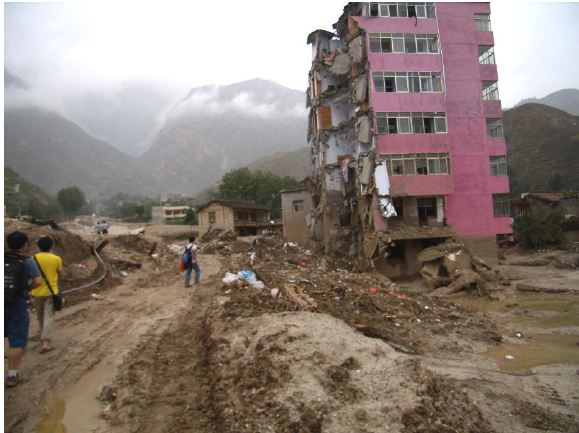
Fig. 12. The devastating amount of sediment and debris transported onto the existing alluvial fan as a result of the major debris flow of Zhouqu, China, 2010.